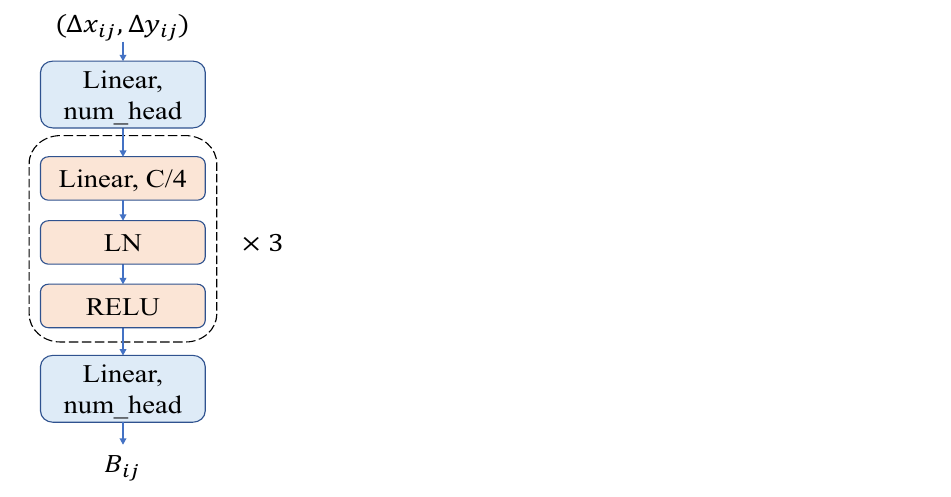
Figure A1. An illustration of the network architecture of DCPE in our network, the num_head means the head number in multi-head self-attention, and C represents the embedding dimension of each token.